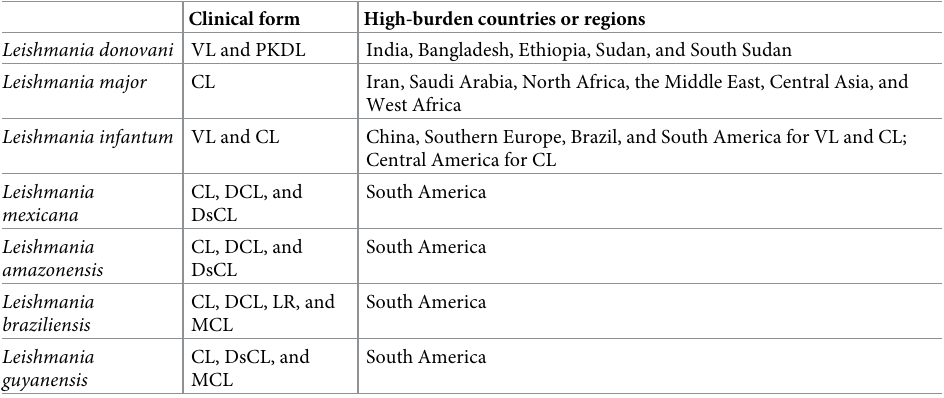
Table 1. Clinical and epidemiological characteristics of selected Leishmania species. Clinical form High-burden countries or